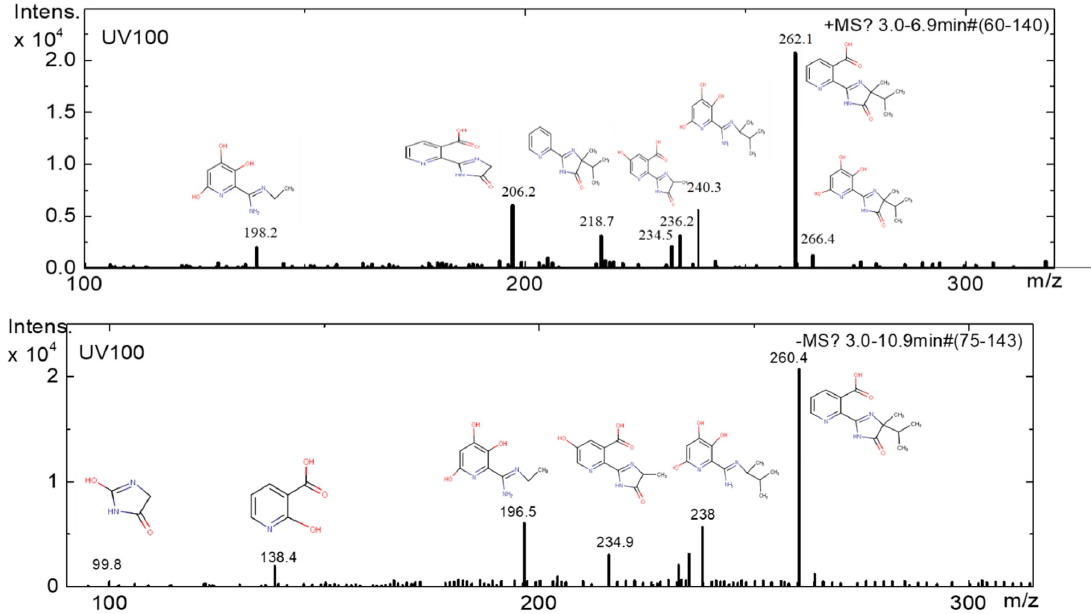
Figure 15. MS (positive and negative) mode of Imazapyr before irradiation.